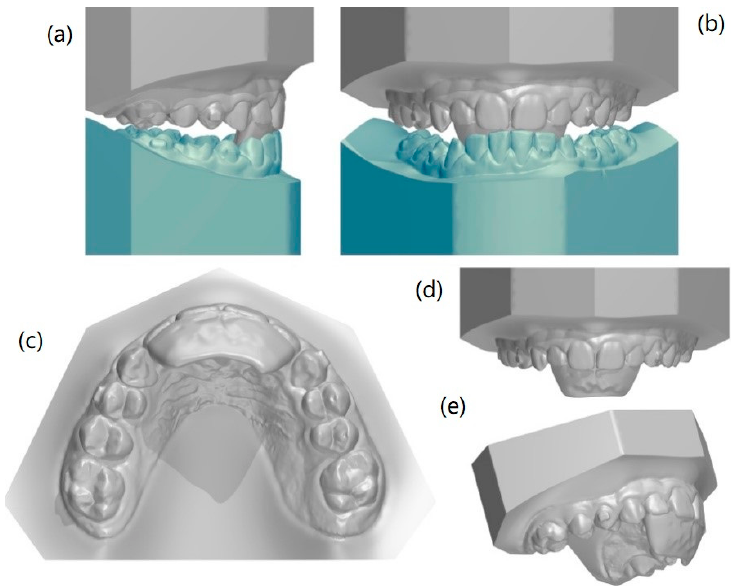
Figure 2. ( a – e ) Digital planning of F22 Young treatment.